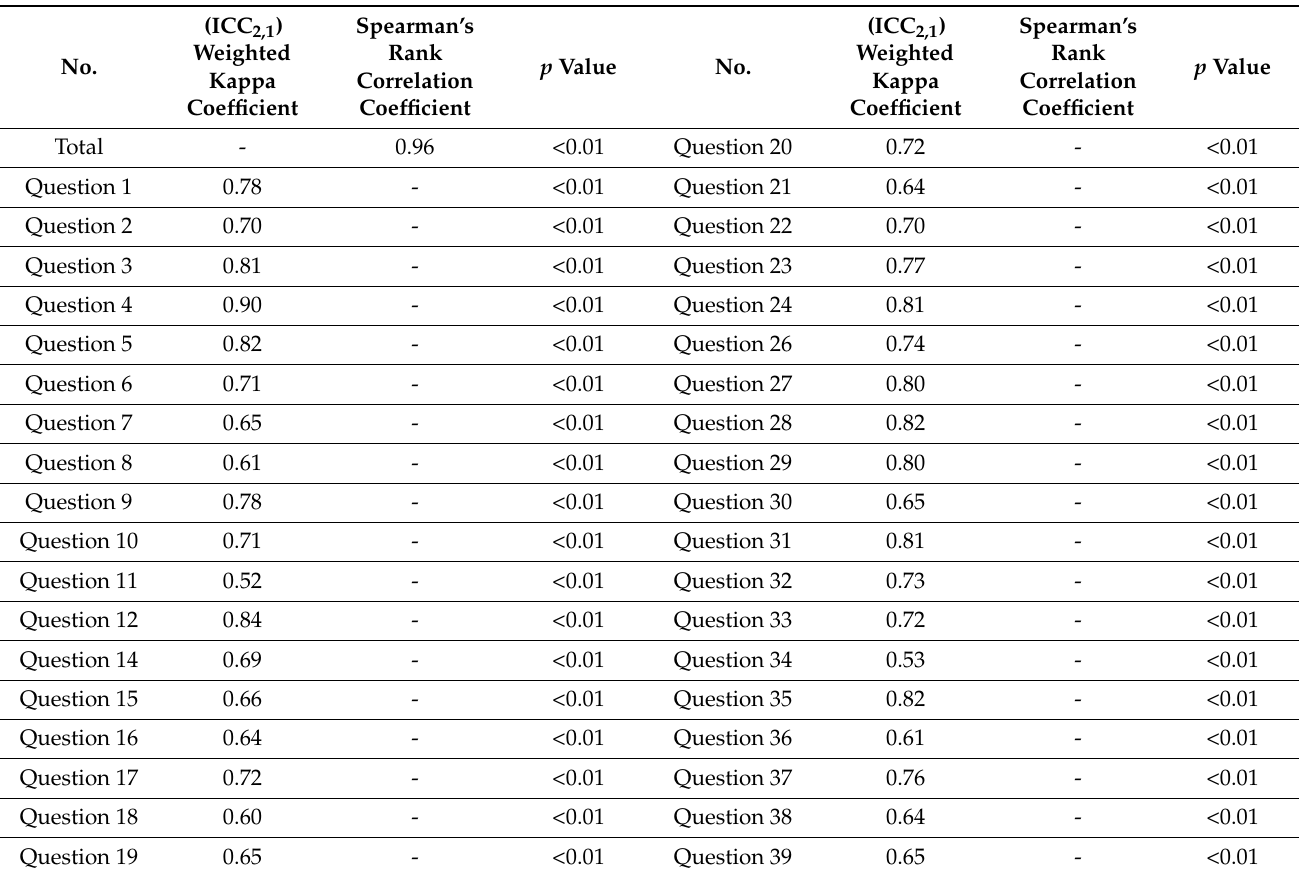
Table 6. Test–retest reliability of the 37-item